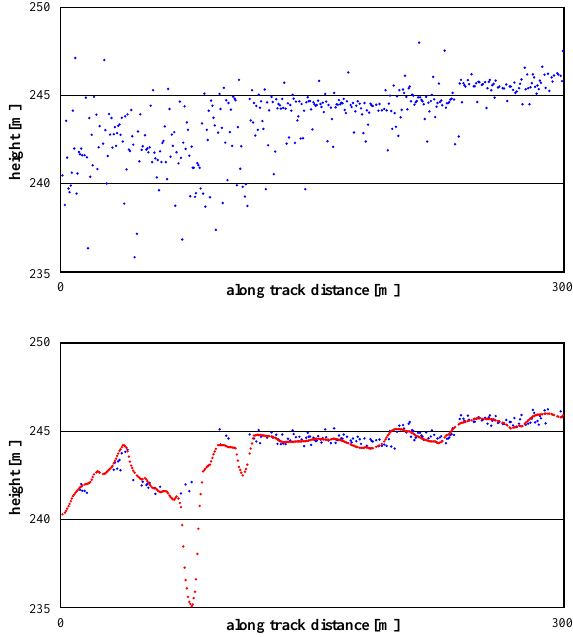
Figure 3: The upper panel shows the signal photons of a 300 m long segment. The distribution of signal photons in the left half of the panel vividly demonstrates the difficulty to discern the real surface. This is different in the right half where the photons are closely clustered around the surface. The lower panel shows the result of filtering with the signal photons clustered along a much narrower band. The red dots show the true surface and the good agreement between blue and red dots show the success of the filtering